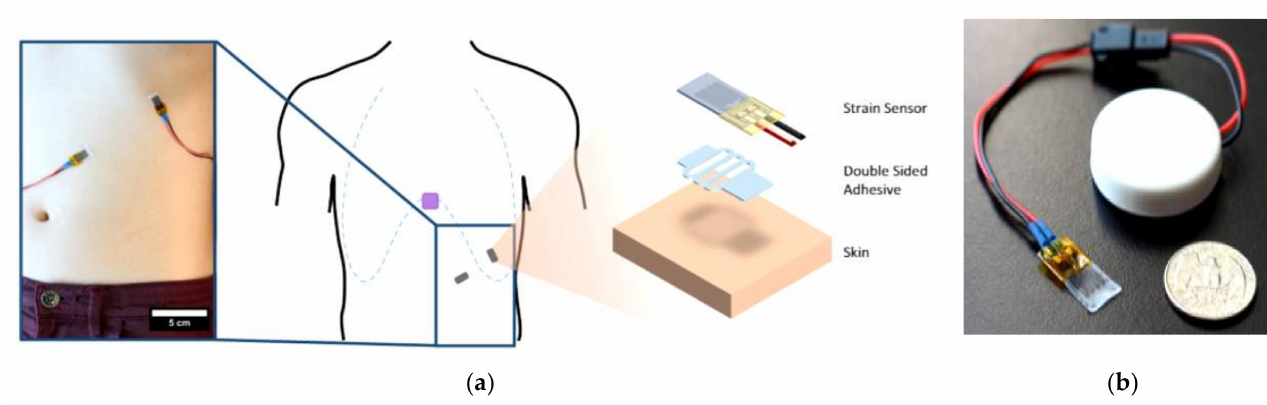
Figure 5. Strain sensors placed on the ribcage and abdomen ( a ); developed sensing unit equipped with a strain sensor ( b ) [61].